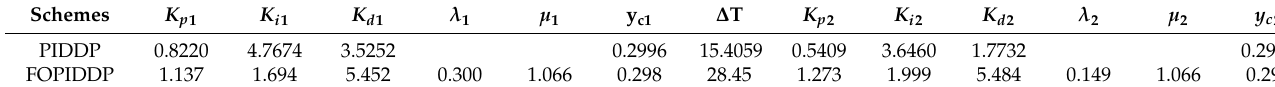
Table 4. Optimal solution of the best solution.